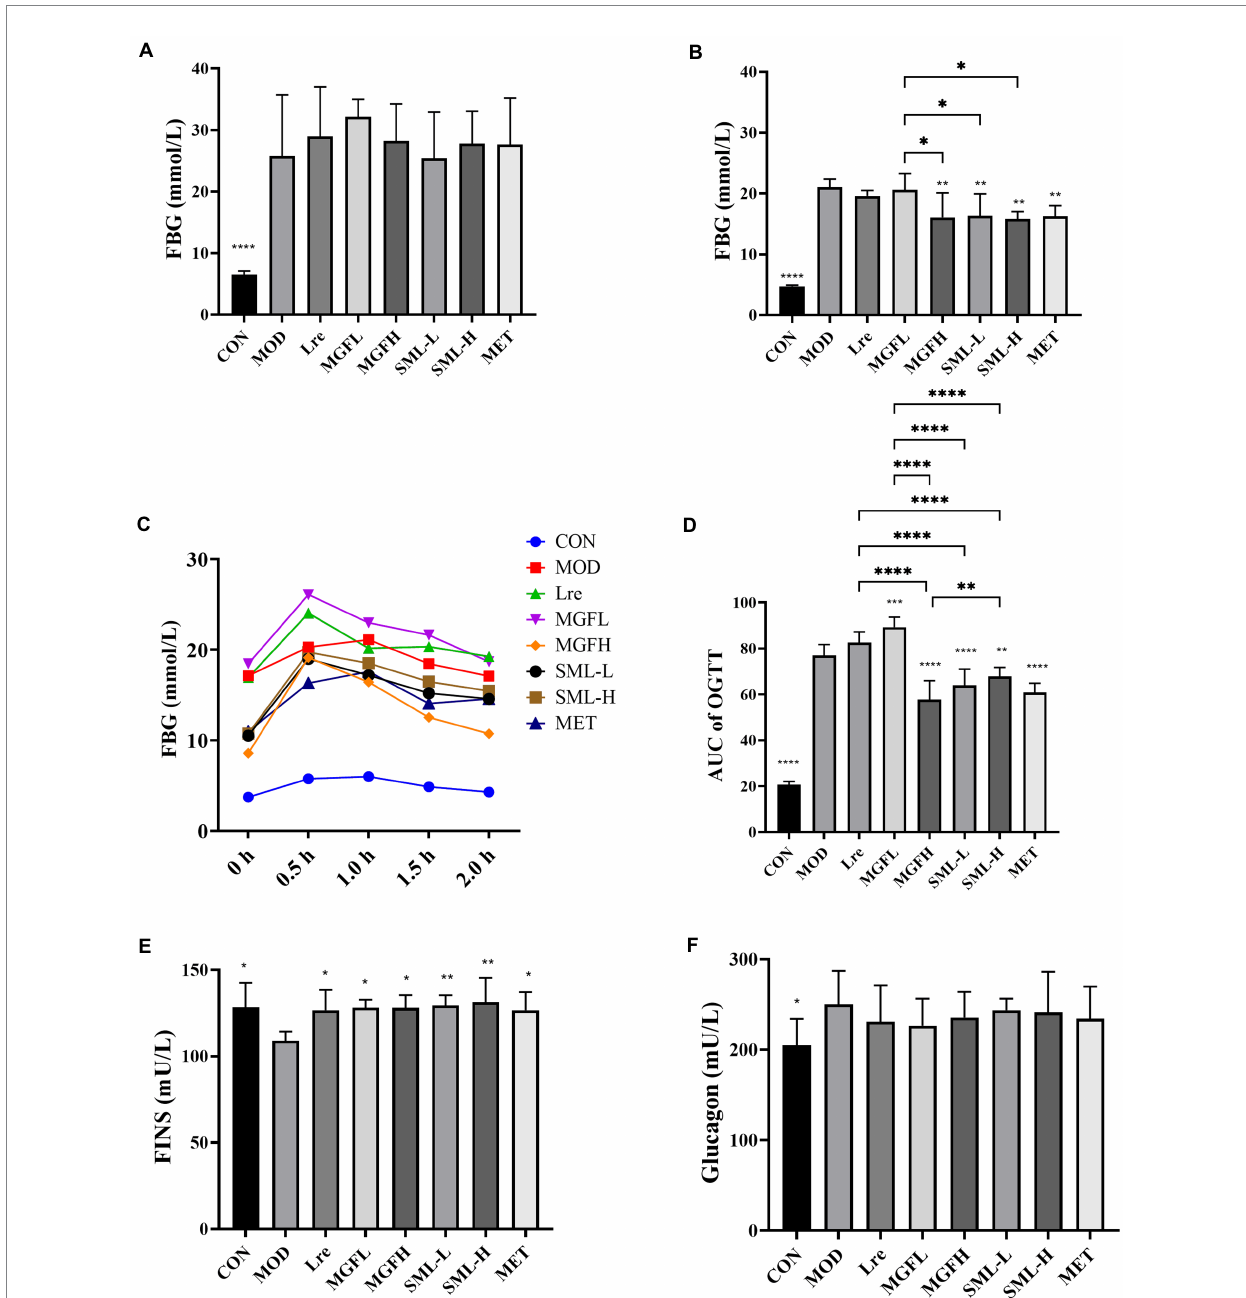
FIGURE 1 Effects of SML on glucose metabolism. (A,B) , respectively, represented the FBG level before and after SML intervention. (C) was the OGTT curve, and (D) was the AUC of OGTT. (E,F) , respectively, showed FINS and glucagon levels. * p < 0.05, ** p < 0.01, *** p < 0.001, **** p < 0.0001 compared with the MOD, and the SML and its components were